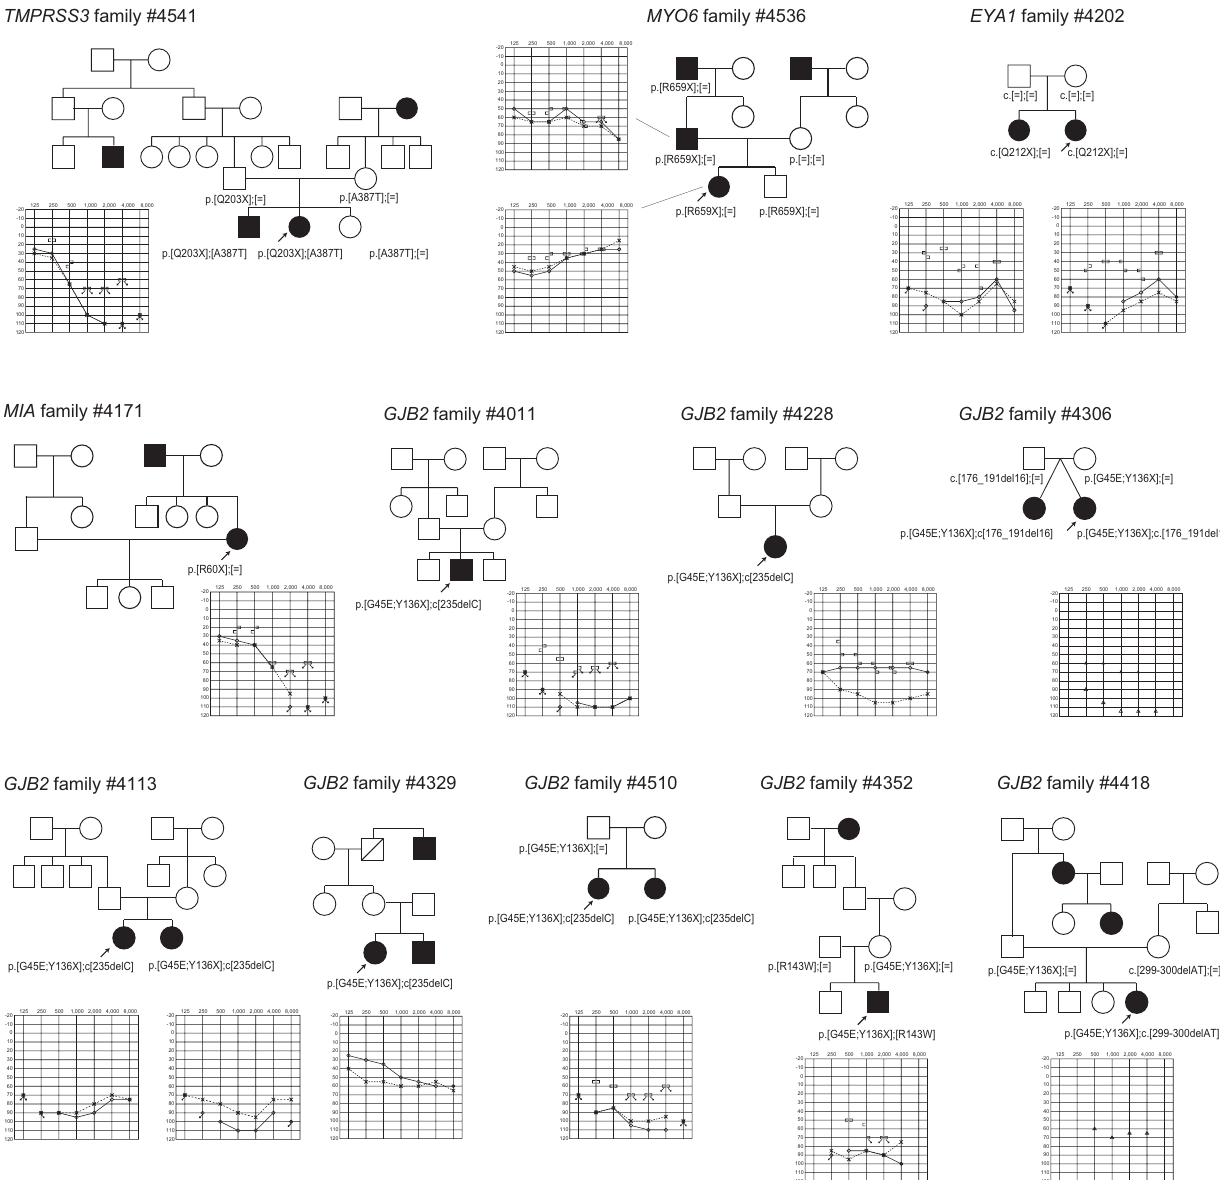
Figure 2. The pedigrees and audiograms of the patients with nonsense mutations after confirmation by Sanger sequencing.